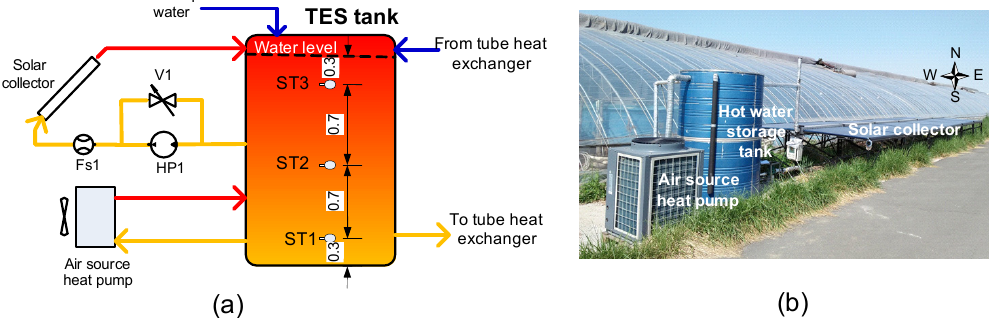
Figure 5. ( a ) Schematic of a thermal energy storage (TES) unit. ( b ) Photograph of the TES unit in Shouguang City.